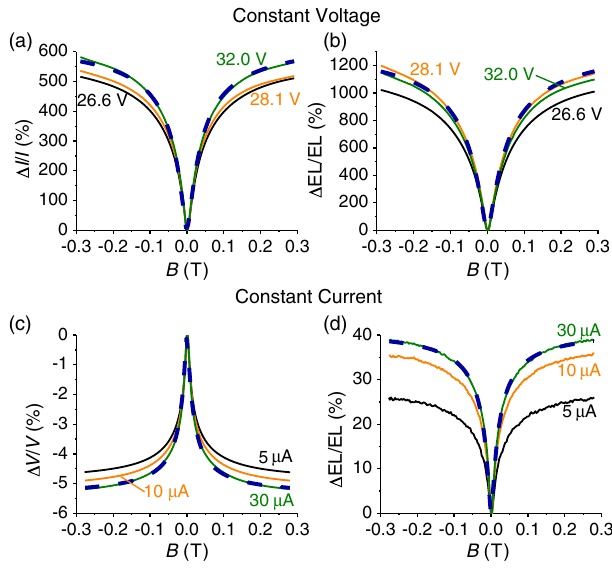
FIG. 6. (a) Magnetoconductance and (b) magnetoelectrolumi- nescence after device conditioning for three representative constant voltages. (c) Magnetovoltage and (d) magnetoelectro- luminescence after device conditioning for three representative constant currents. The same color is used throughout the figure to designate measurements with a comparable current density. Thick dashed lines are non-Lorentzian (as defined in text) fits to the largest displayed curve in each panel.